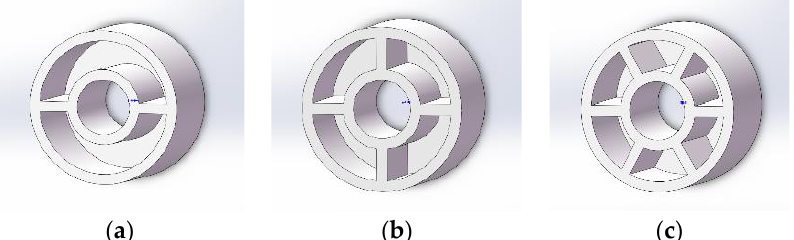
Figure 14. Three particle impact damper structures. ( a ) Two cavities; ( b ) Four cavities; ( c ) Six cavities.